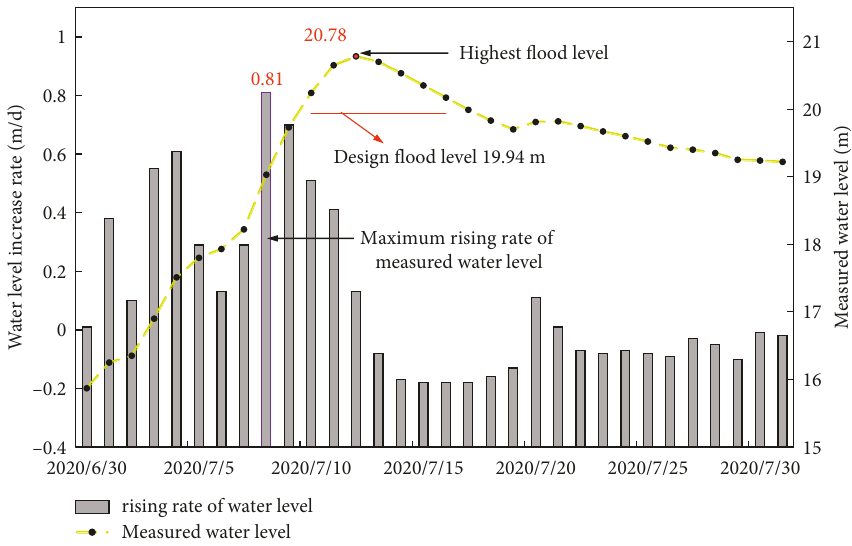
Figure 3: Curve of water level change outside the cofferdam during flooding.